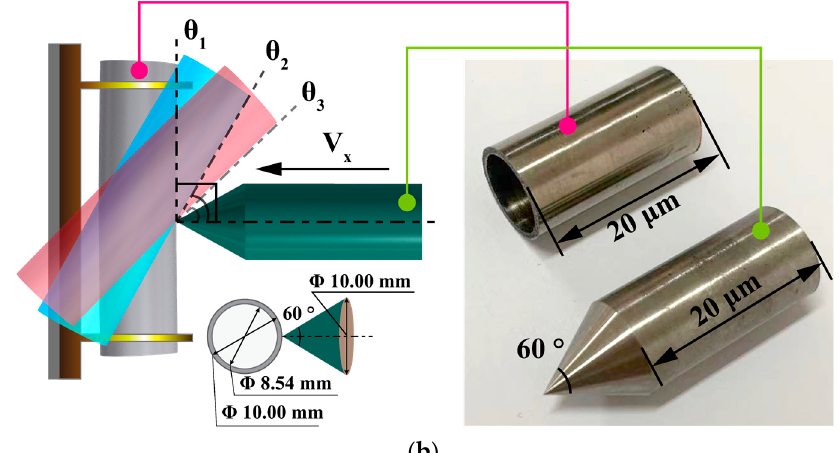
Figure 1. Schematic of self-developed impact wear tester ( a ): (1) water pump; (2) sample; (3) force sensor; (4) mass block; (5) displacement sensor; (6) liner guide; (7) tie rod; (8) voice coil motor, and schematic diagram of motion ( b ).